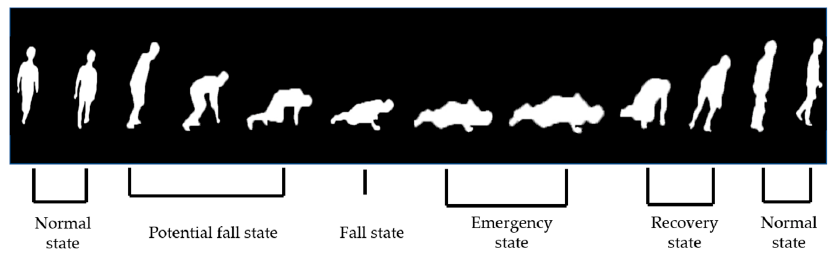
Figure 7. State classification during the fall process.